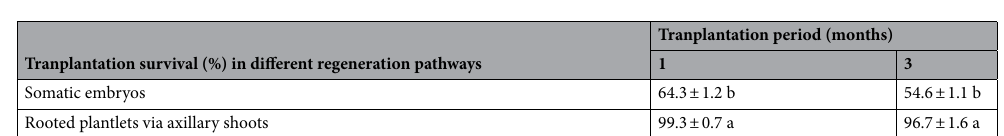
Figure 3. Recovery of Euryodendron excelsum somatic embryos and transplantation . ( a ) A single somatic embryo developed a radicle on WPM with 0.2 mg/L zeatin after 6 weeks. ( b ) Somatic embryos developed roots on WPM with 0.2 mg/L NAA after 6 weeks. ( c ) Somatic embryos from developed normal plantlets after three months. Bars: 1.0 cm ( a , b ); 5.0 cm ( c ).